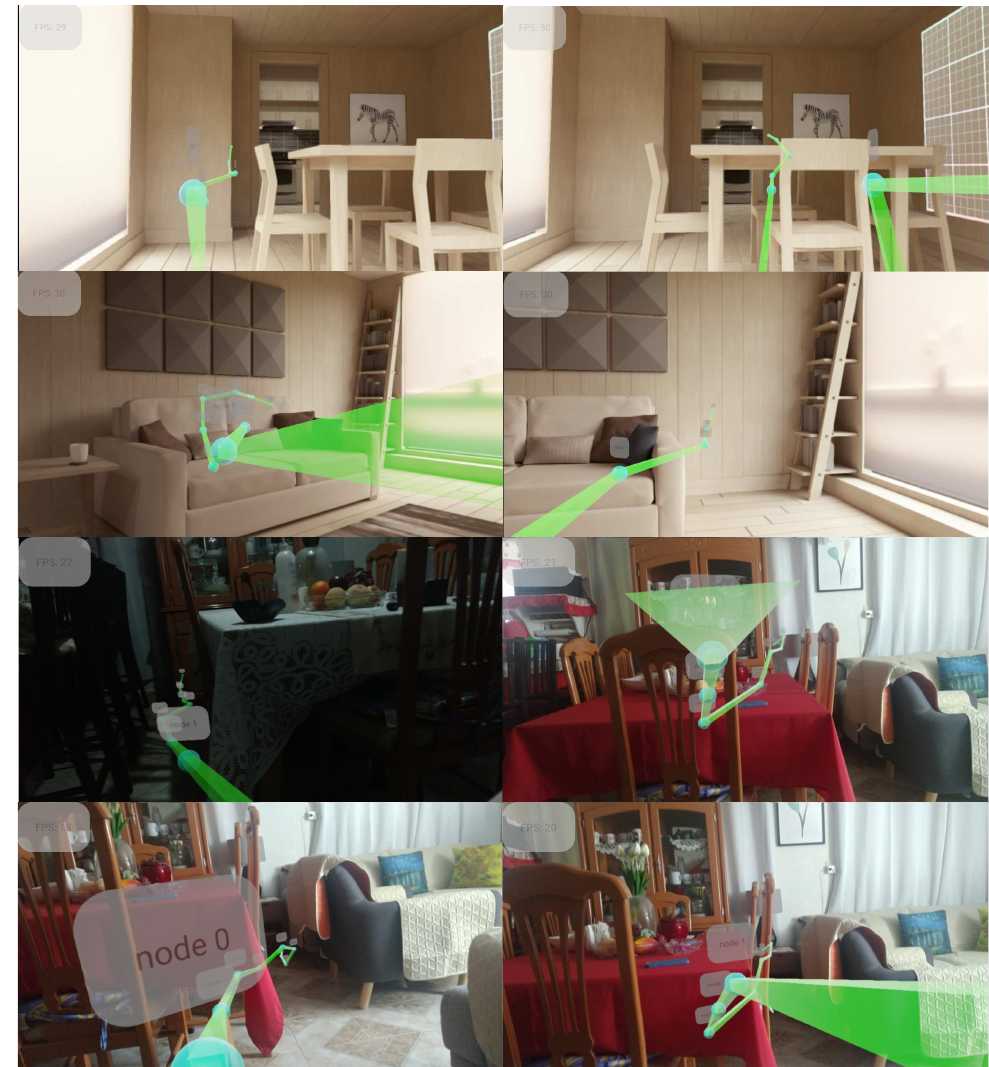
Figure 12. The path generated for augmented reality experiences in real-time. A line indicates the path to display virtual elements to avoid physical